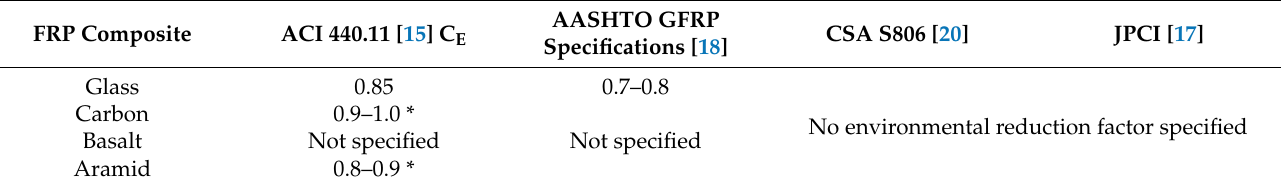
Table 6. Environmental reduction factors on FRP reinforced concrete